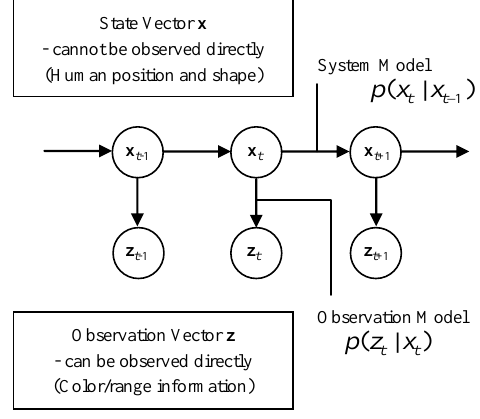
Figure 1. General state space